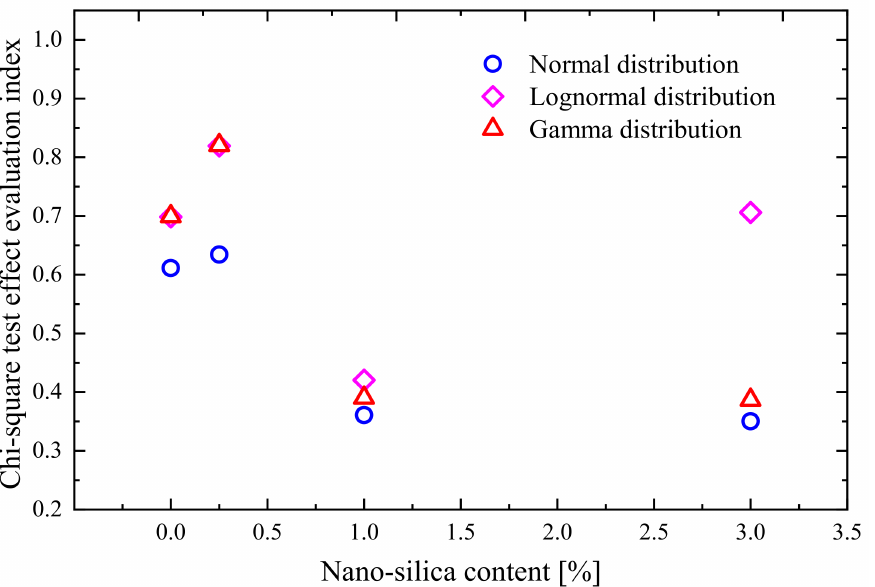
Figure 12. CEI results for the normal, lognormal, and Gamma distributions of the median pore